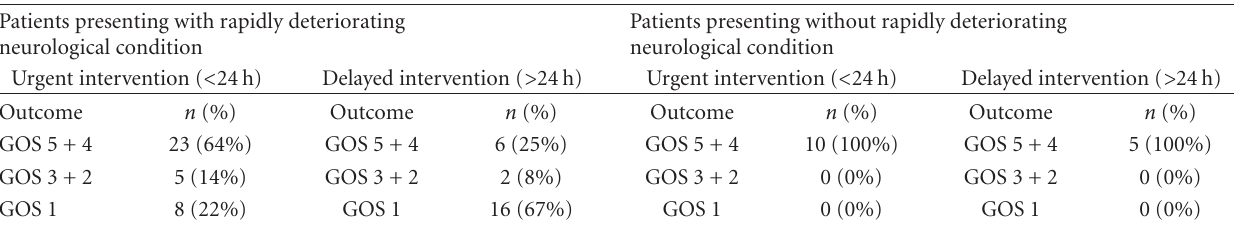
Abbreviations: GOS = Glasgow Outcome